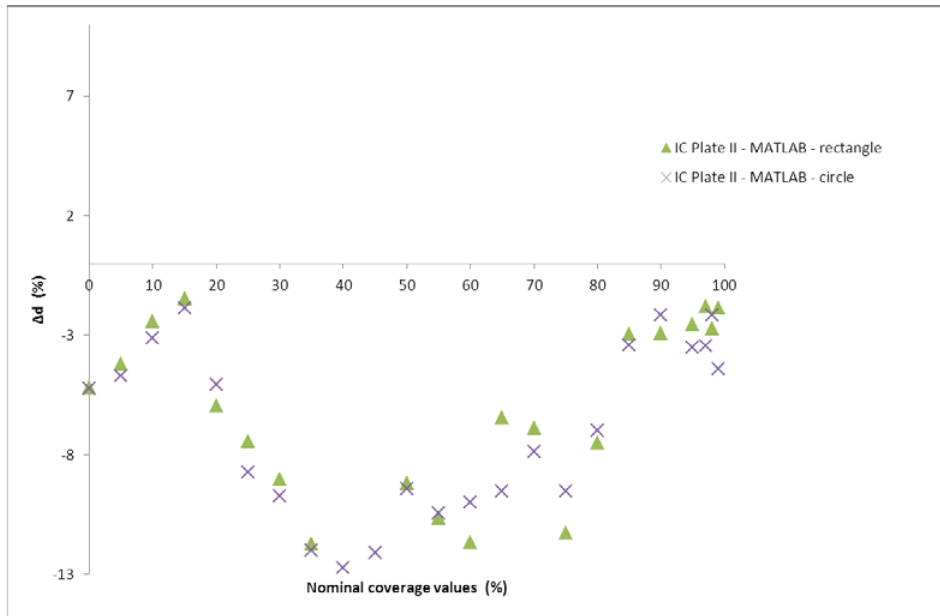
Figure 13. Comparison of coverage values calculated by IC Plate II and Matlab (circle and